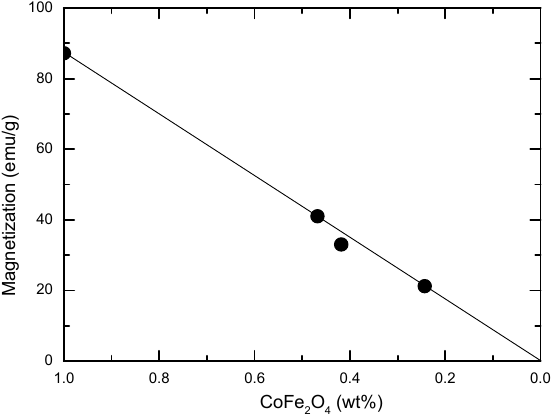
Figure 9. Magnetizations at T = 4.2 K as a function of CoFe 2 O 4 content in CoFe 2 O 4 @SiO 2 @AuN nanocomposites. The solid line gives the expected trend in a simple dilution magnetic model.